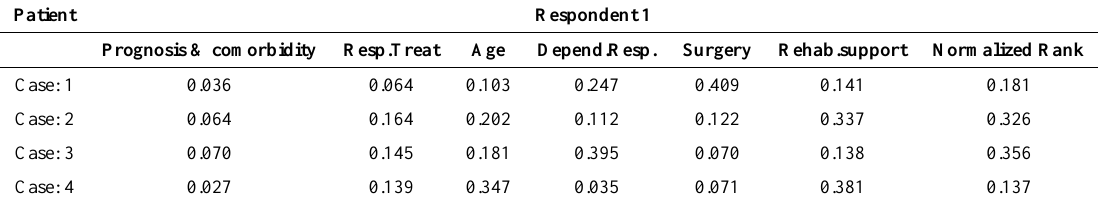
Table 14. Patient Rank with the Multi-Factor Triage Algorithm, (MUFTA) (Expert 1)